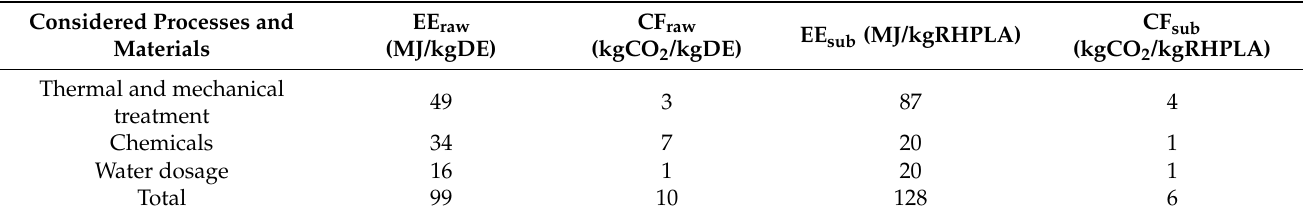
Table 6. Data results of the embodied energy (EE) and carbon footprint (CF) for the raw process (raw) and the new proposed process (sub) for silica